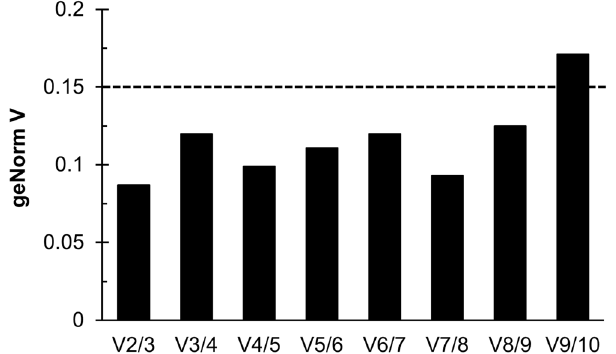
Figure 4. Minimum number of reference genes. The pair-wise variation Vn/Vn + 1, where n represents the number of RGs used in the normalization factor (NF), was calculated by geNorm to determine the minimum number of RGs required for normalization. A geNorm V value below 0.15 signifies that no additional benefit is gained from increasing the number of reference genes from n to n + 1. The dashed line represents a V value of